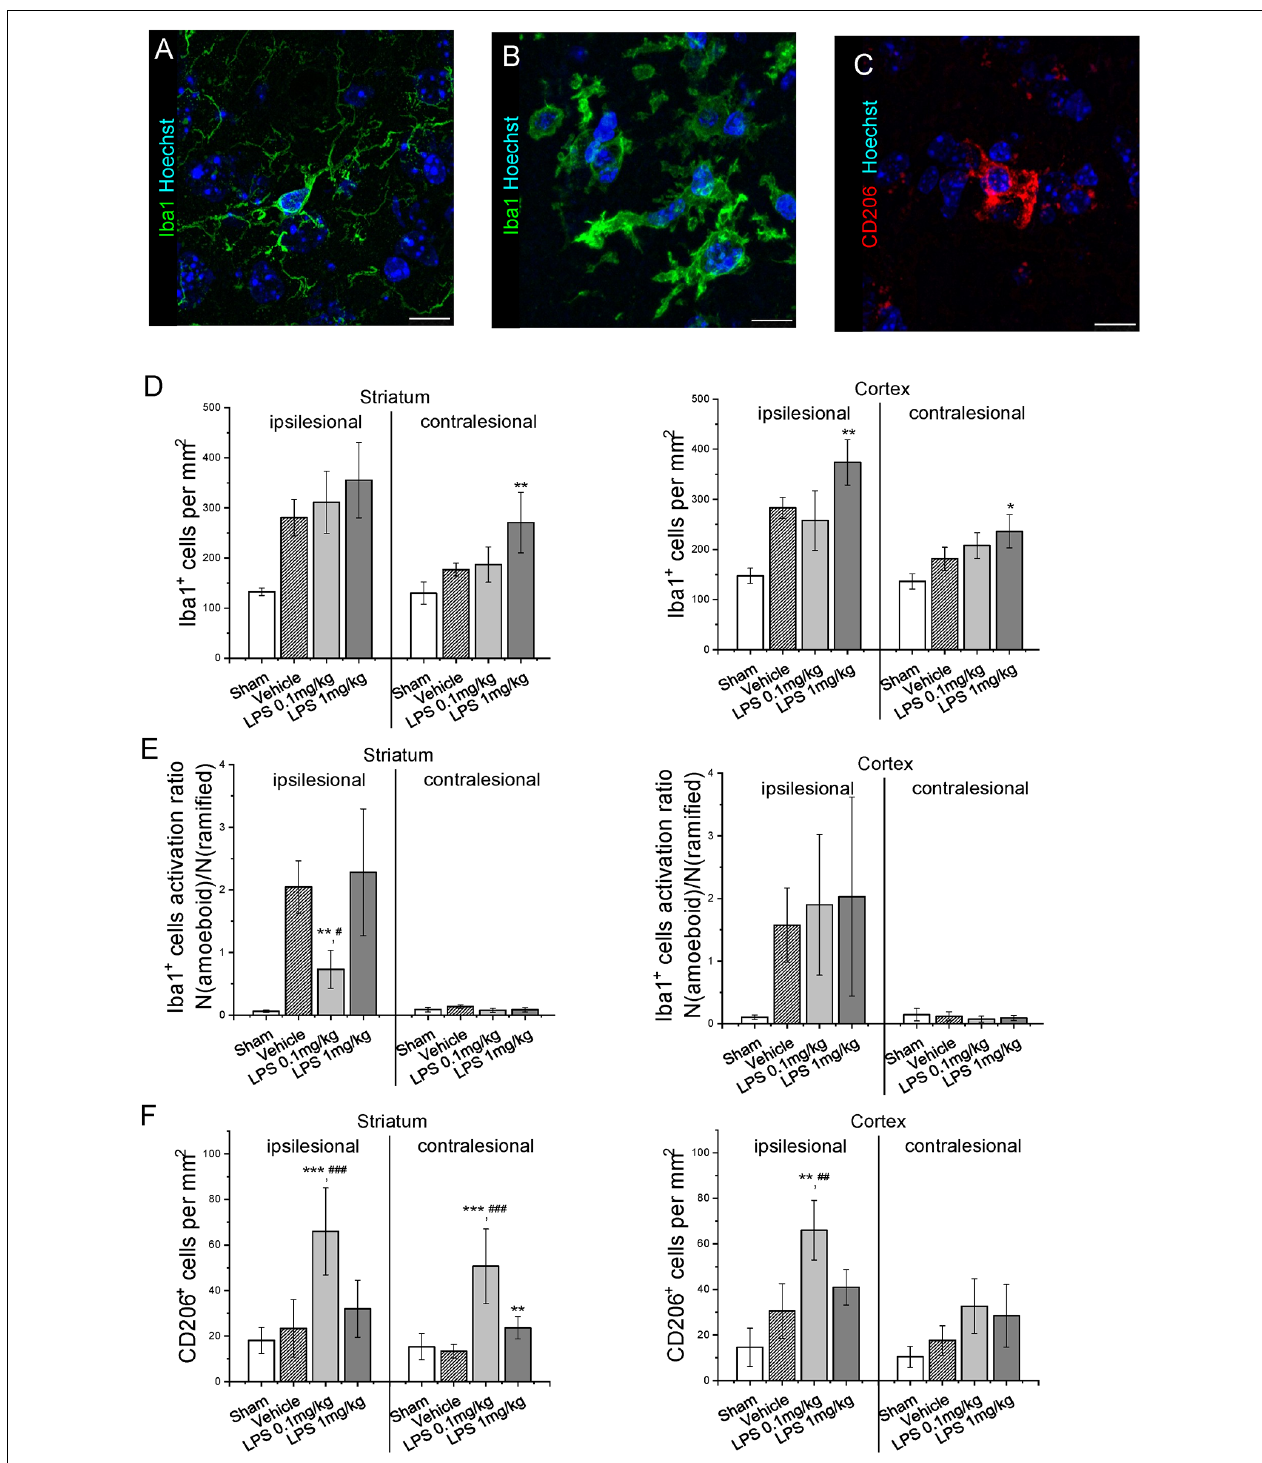
FIGURE 4 | Post-ischemic low dose LPS administration attenuates microglia/macrophage activation. Panels (A,B) show representative ramified and amoeboid Iba1+ microglia/macrophages, (C) representative anti-inflammatory CD206+ microglia/macrophages. Iba1+ cell density (D) , Iba1+ cell activation index (E) and CD206+ cell density (F) were quantified in striatum and cortex of mice exposed to sham surgery or transient intraluminal MCAO. Vehicle or LPS (0.1 or 1 mg/kg) were intraperitoneally administered at 24 h after MCAO. Data are means ± SD values. * p < 0.05/* p < 0.01/* p < 0.001 compared with vehicle group, # p < 0.05/ ## p < 0.01/ ### p < 0.001 compared with LPS 1 mg/kg ( n = 6 animals/group). Scale bars, 10 µ m.